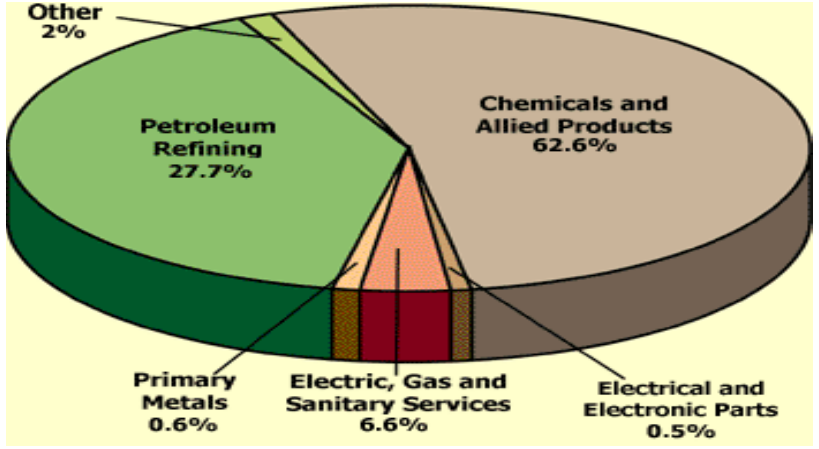
Figure 4. Generation of Hazardous Waste by Industry in Texas, 2001.